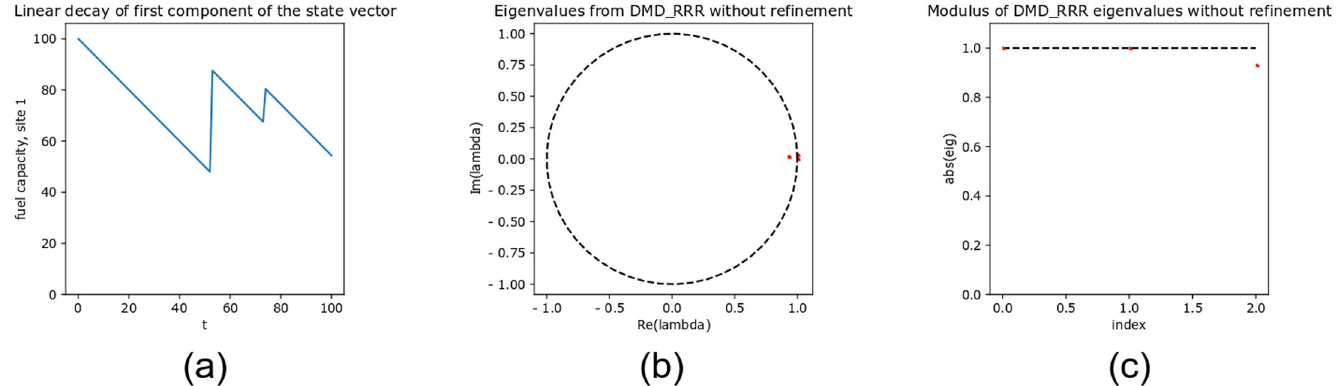
Fig 28. (a) Linear decay with random jumps. (b) DMD_RRR spectrum corresponding to (30). (c) Modulus of the spectrum.